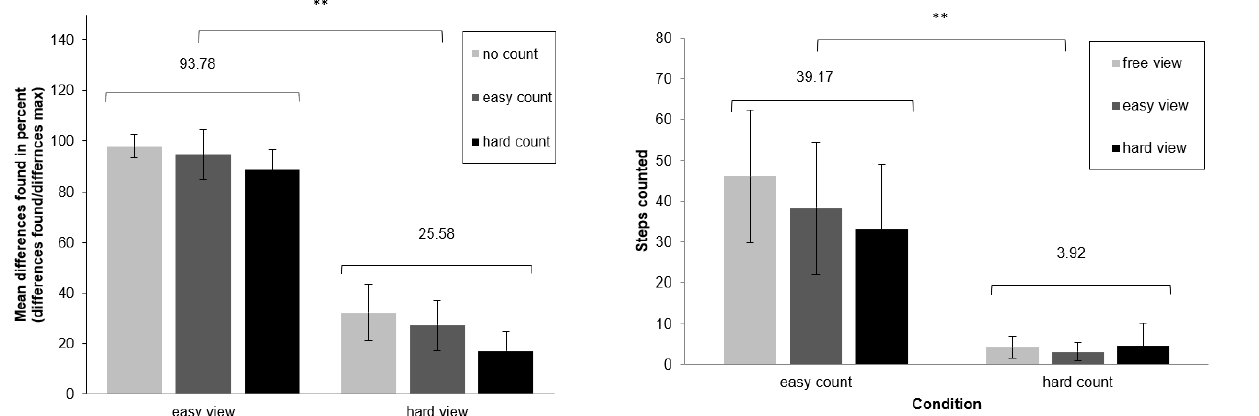
Figure 4. Manipulation checks for levels of difficulty suggest that both difficulty manipulations were effective. Participants likewise completed significantly more counting steps in the easy count condition (M = 39.17) than they did in the hard count condition (M = 3.92), and irrespective of view